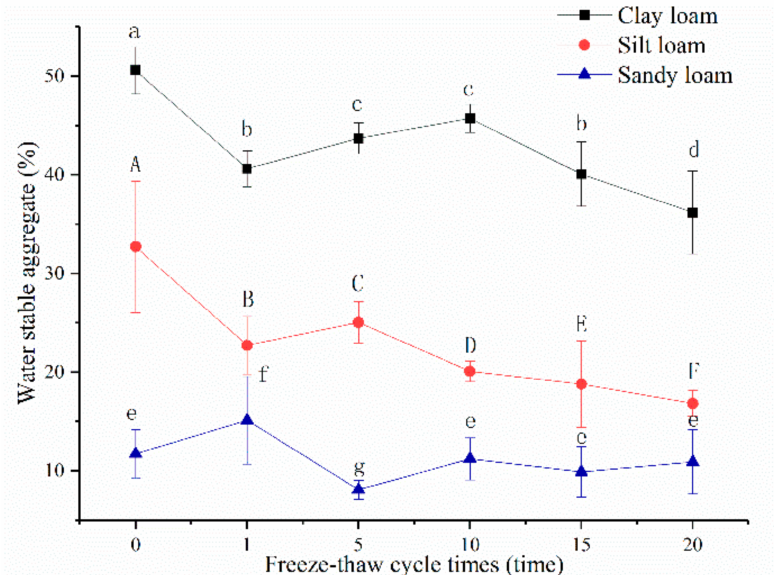
Figure 4. Relationships between soil water stable aggregates and freeze-thaw cycles of three soils. Note: The letters indicated whether the differences in the test results were significant or not. “a, b, c, d” stands for clay loam, “A, B, C, D, E, F” stands for silt loam, “e, f, g” stands for sandy loam. Different letters indicate a significant difference of test results among the different freeze-thaw cycles and soils at the 0.05